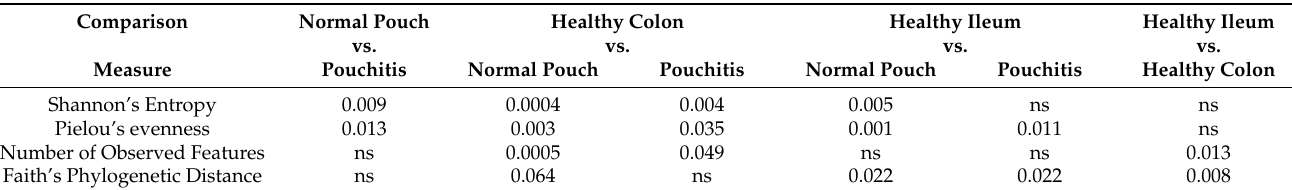
Table 2. Summary of pairwise group comparisons for four alpha diversity indexes. Benjamini and Hochberg corrected p -values ( q -values) for Kruskal–Wallis tests are shown; “ns”: q -value > 0.05.